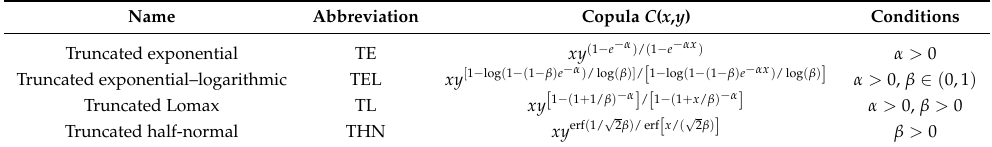
Table 2. Copulas derived from Theorem 1 and Lemma